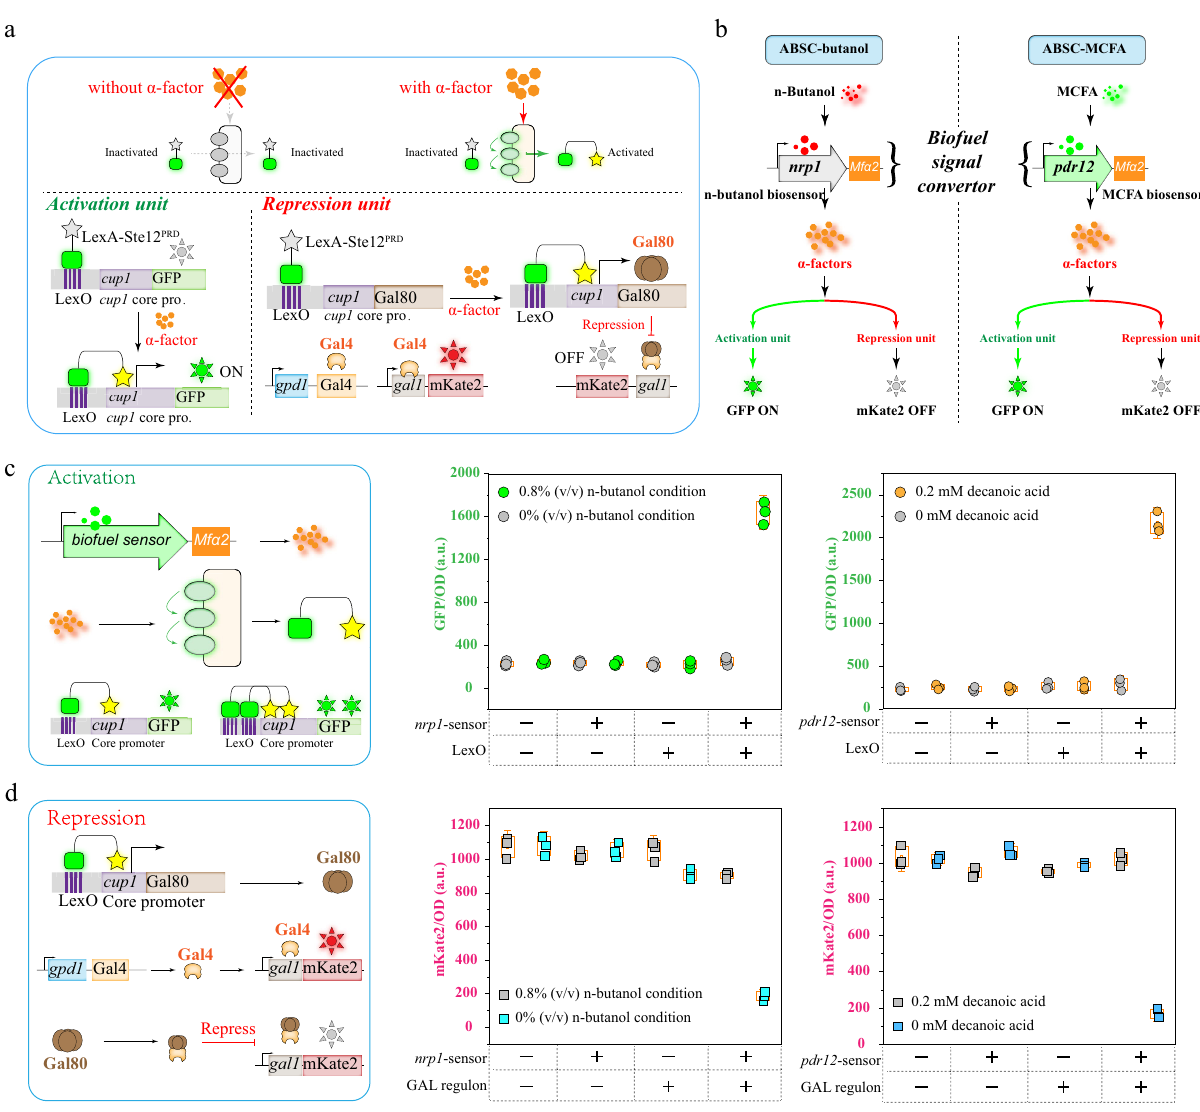
Fig. 4 Constructing and characterizing ABSC. a , b The schematic diagram of the autonomous bidirectional signal conditioner (ABSC). c The activation unit of ABSC in biofuels conditions was characterized by GFP. d The repression unit of ABSC in biofuels conditions was characterized by mKate2. c , d Values and error bars represent the mean values and standard deviations of three biological repeats, respectively. Source data are provided as a Source Data fi